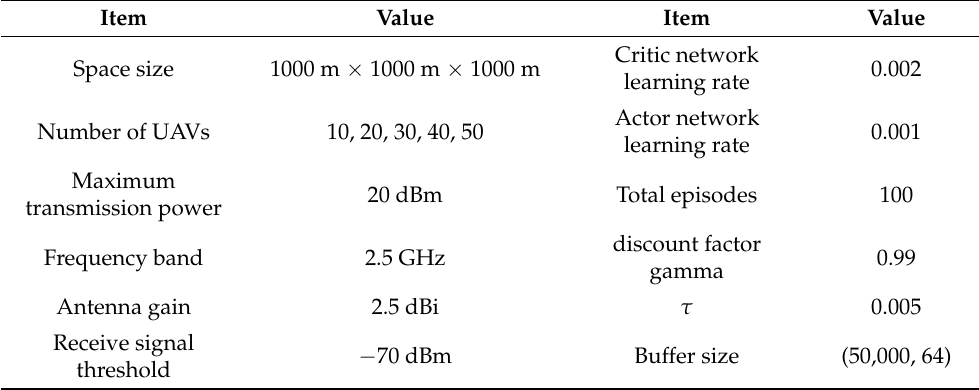
Table 2. Simulation